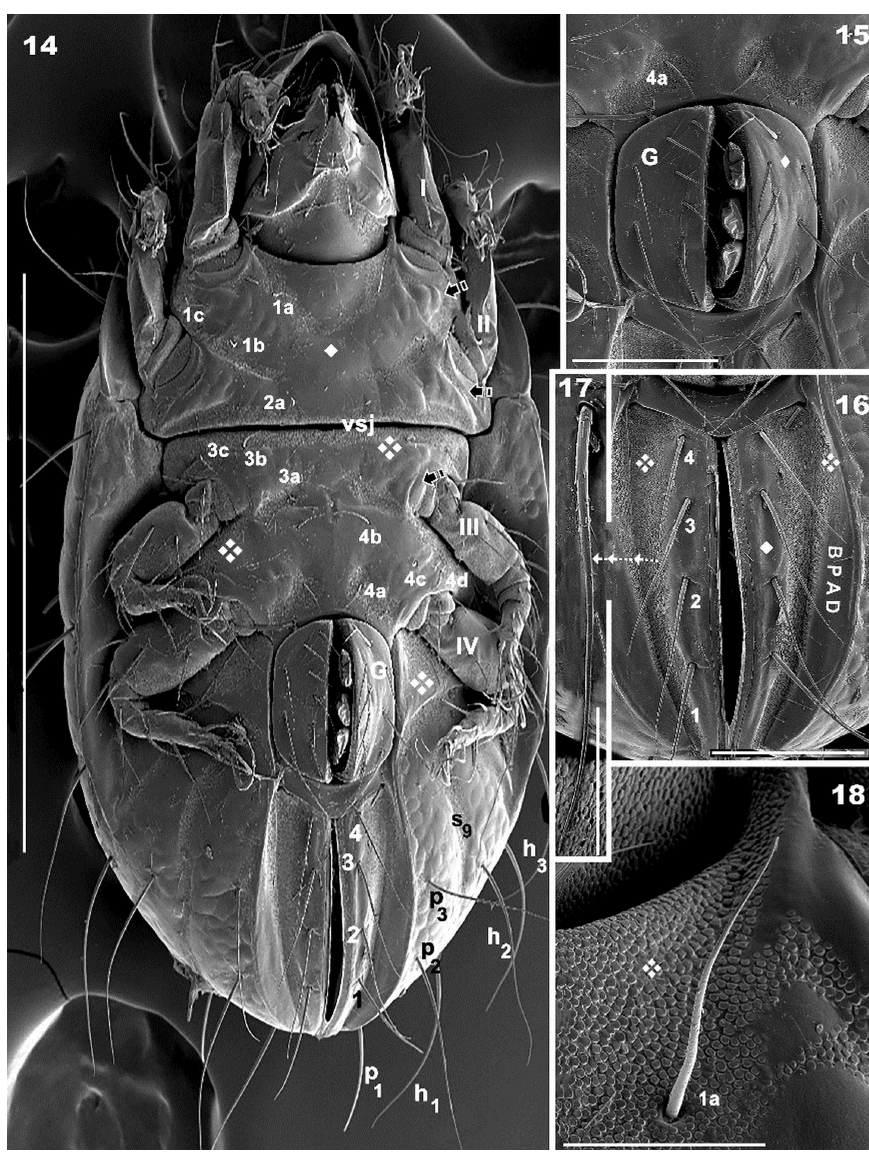
Figures 14–18. Meristacarus perikopesis sp. n. Adult with cerotegumental layer. SEM micrographs. 14 ventral view 15 genital zone 16 ano-adanal region 17 adanal setae 18 epimeral setae 1a. Scale bars: 500 μm ( 14 ); 100 μm ( 15 ); 100 μm ( 16 ); 25 μm ( 17 ); 30 μm ( 18 ). blade. Setae u laterally flattened on all legs (Figures 23, 24, 25, 26, 27), with flap hous- ing s setae on claw (Figure 27 indicated by Solid upwards arrow). Famulus spur-shaped (Figure 28), setal formulae I (0-4-2-2-16-1) (2-1-2); II (0-5-4-4-15-1) (1-1-1); III (2- 4-3-4-13-1) (1-1-0); IV